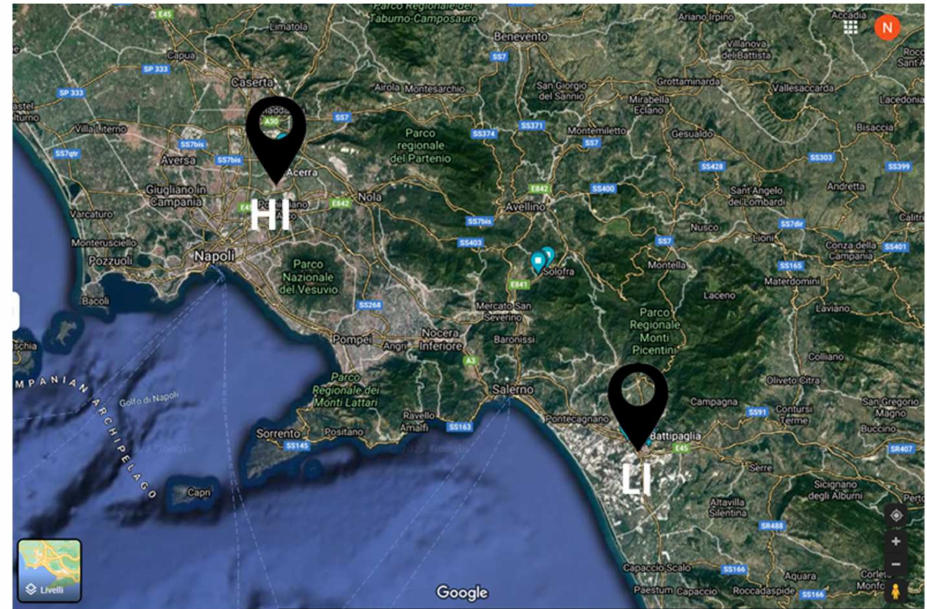
Figure 1. Localization of the high and low environmental impact areas, Acerra (HI) and Battipaglia